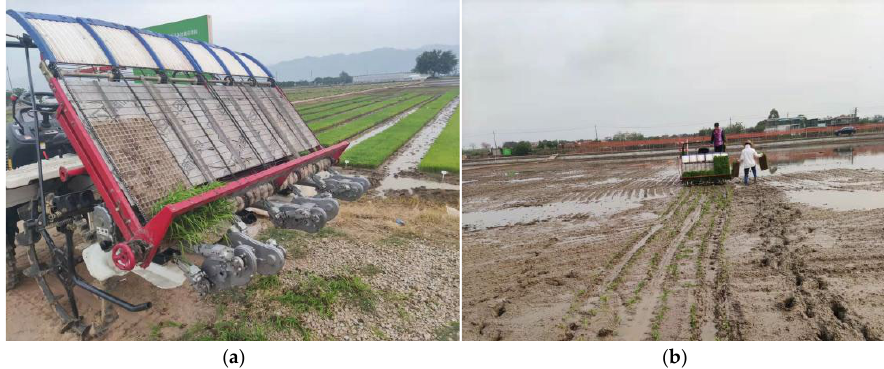
Figure 11. ( a ) Seedling picking experiment; ( b ) field experiment.